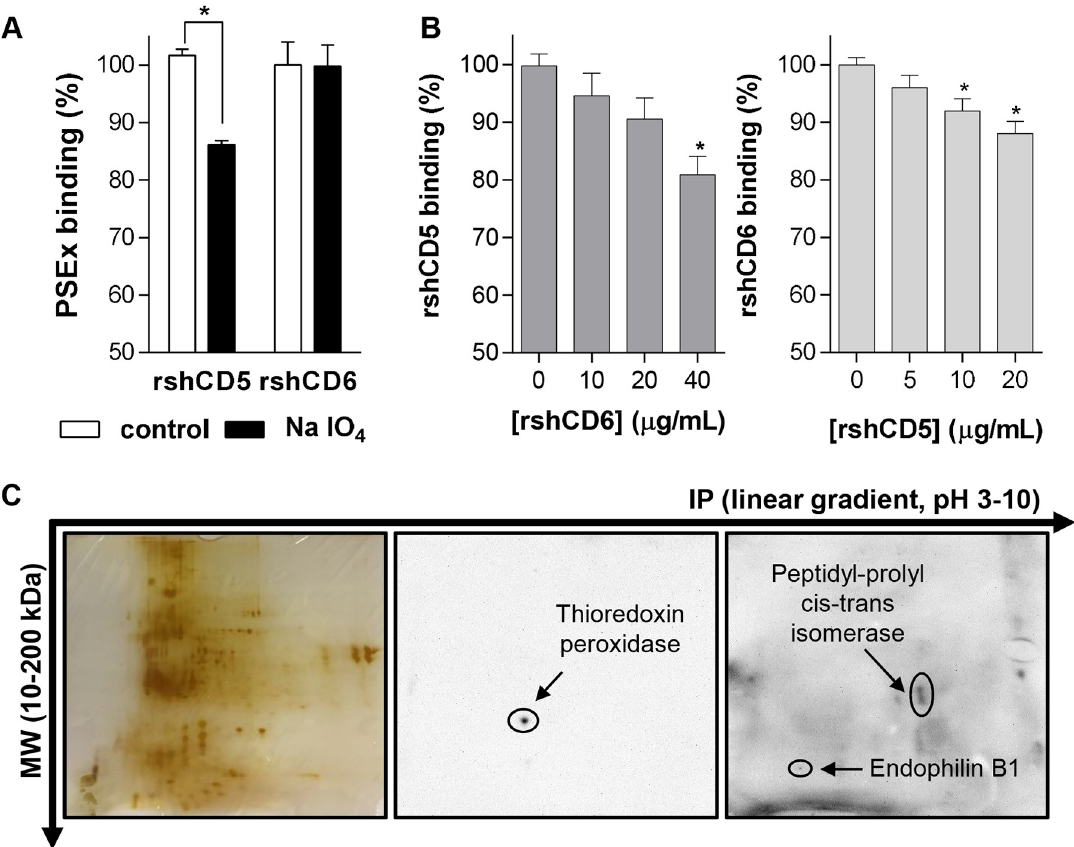
Fig 2. Tegumental antigens recognized by rshCD5 and rshCD6 are different. ( A ) ELISA assays showing binding of rshCD5 and rshCD6 to PSEx-coated plates undergoing metaperiodate treatment (NaIO 4 ) or not (control). Binding to metaperiodate-resistant antigens was assessed as the percentage of absorbance values in treated wells respect to untreated wells (triplicates in each case). ( B ) Competition binding assays in which binding of a fixed amount of biotinylated rshCD5 (20 μ g/mL; left ) or rshCD6 (10 μ g/mL; right ) to PSEx-coated ELISA were competed with increasing amounts of unlabeled rshCD6 and rshCD5 proteins, respectively. Ligand overlapping was assessed (in triplicates) as the percentage of absorbance values in competed wells respect to non-competed wells (0 μ g/ mL of unlabeled protein). ( C ) 2D SDS-PAGE resolved PSEx fractions were either silver stained ( left ) or electro-transferred onto PVDF membranes for further Western blotting with biotin-labeled rshCD5 ( middle ) or rshCD6 ( right ). ( � ) Significant differences (Student’s t- test, P < 0.05) respect to control ( A ) or uncompleted ( B ) wells.